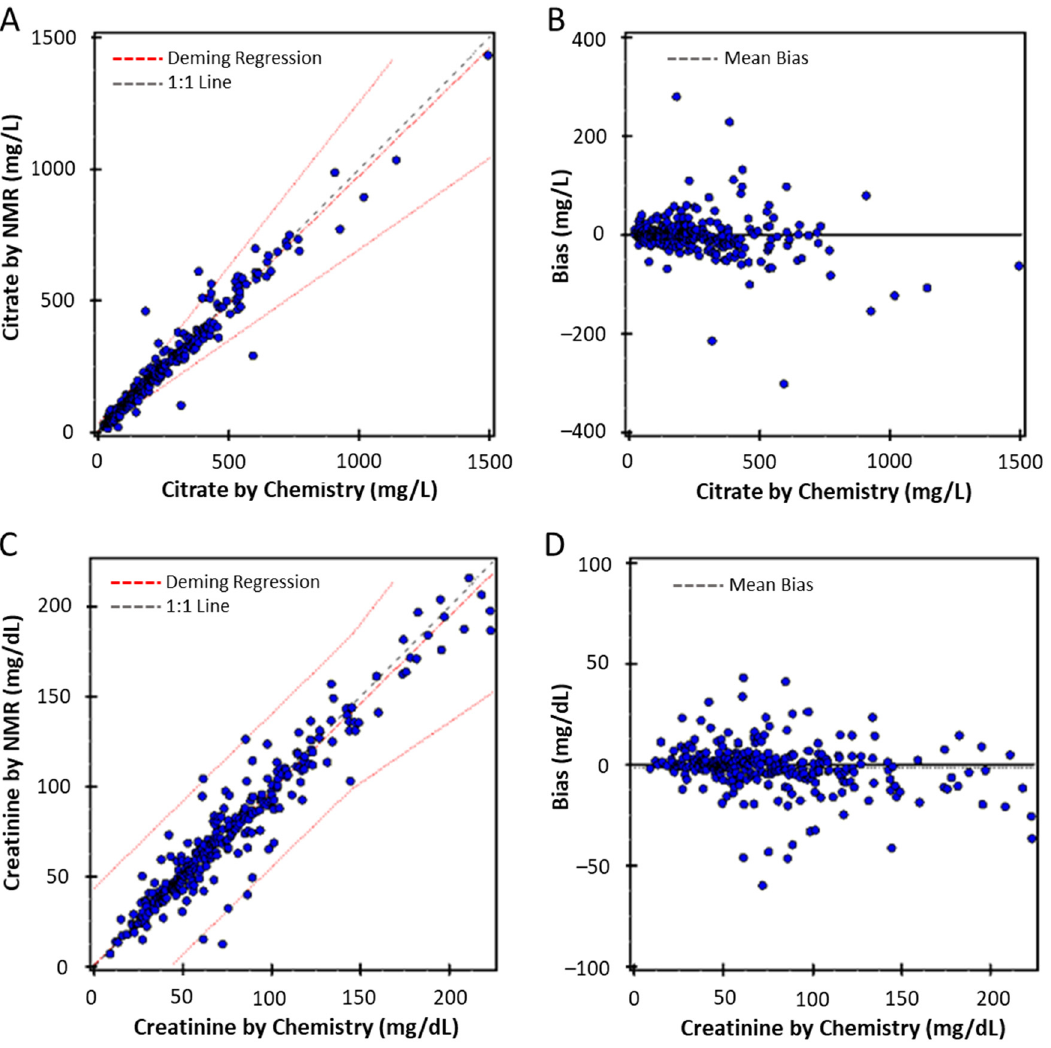
Figure 5. Deming regression comparison between chemistry and NMR measured citrate ( A ) and creatinine ( C ). Bland–Altman plots of the residuals for citrate ( B ) and creatinine ( D ). The limits of agreement (LOAs) are depicted as dotted blue lines and 0% bias is a solid grey line.